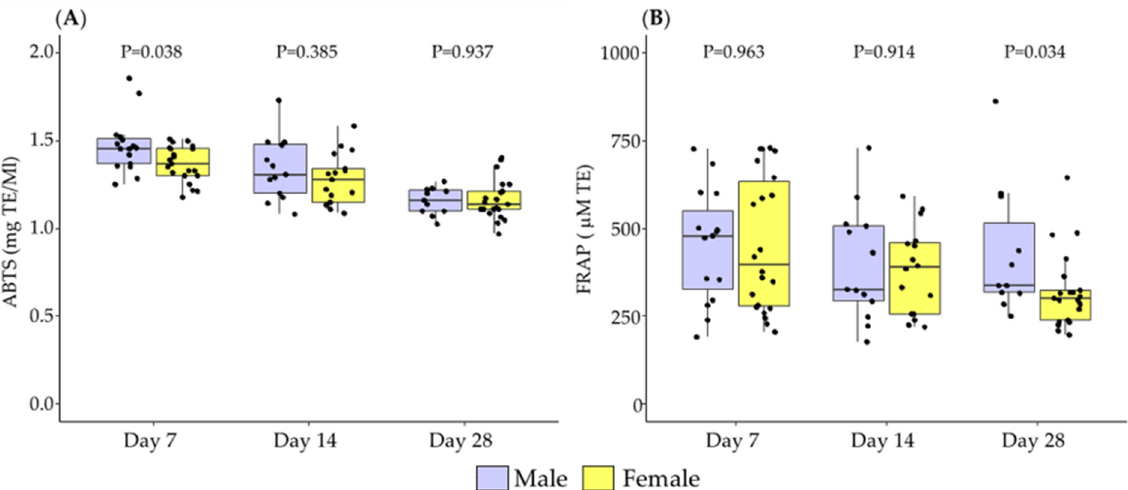
Figure 2. The evolution of breast milk total antioxidant capacity via the ABTS method ( A ), and by FRAP method ( B ) during the first month of lactation according to the sex of the newborn. Data show median and interquartile range [Q1; Q3]. Neonatal sex was compared according to the day of lactation using the Mann-Whitney U test and extracted p -Value ( p ) adjusted by Holm-Bonferroni multiple comparison methods was reported in the figure. TE: Trolox equivalent.